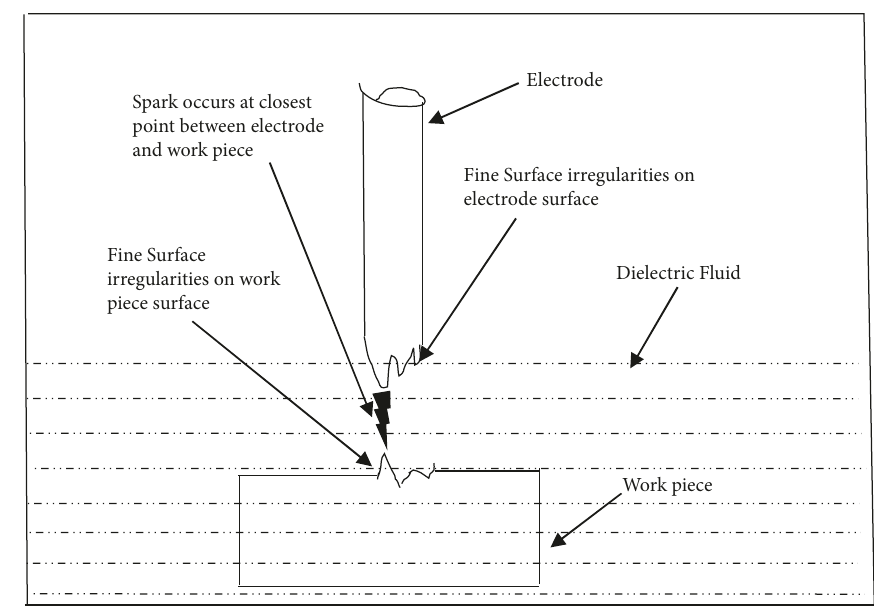
Figure 1: Schematic of sparking occurs at the nearest point in the EDM experimental setup.